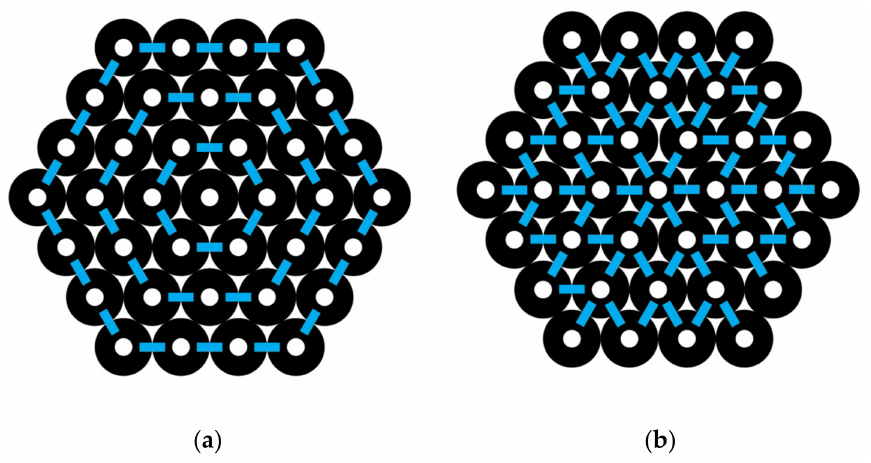
Figure 4. A hexagon-shaped CNT bundle: ( a ) pair interactions oriented around the bundle and ( b ) pair interactions oriented